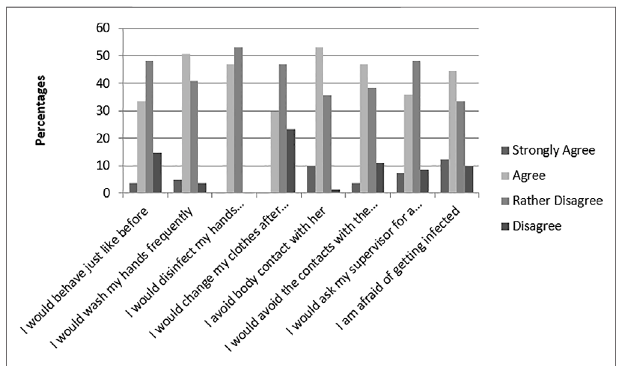
FIGURE 5 | Responses to case scenarios 2.